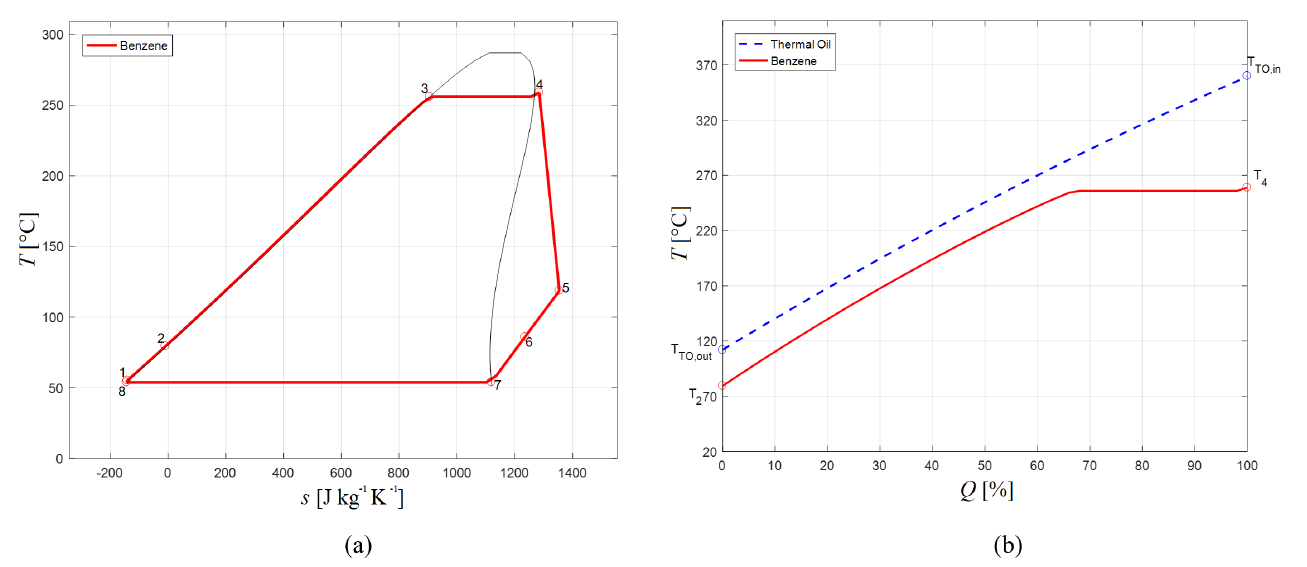
Figure 11. T-s ( a ) and T-Q ( b ) diagrams of the ORC employing Benzene as the working